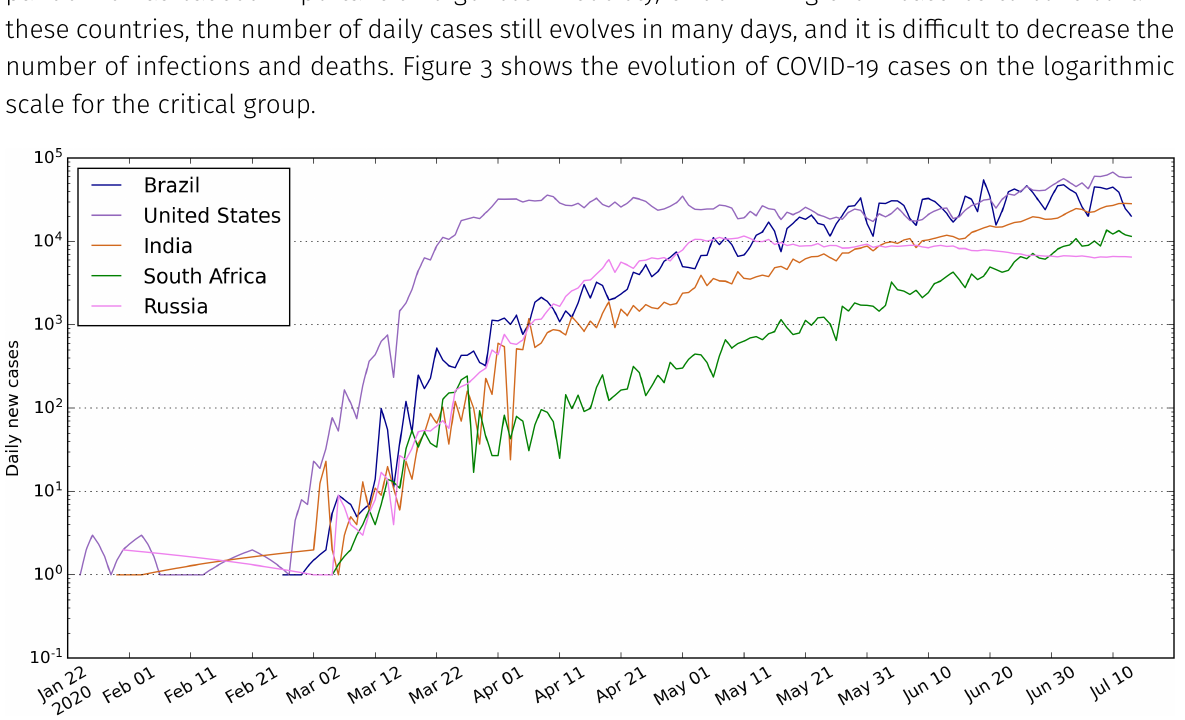
Figure 3. COVID-19 daily cases evolution for critical group countries in log scale. Source Ritchie et al.